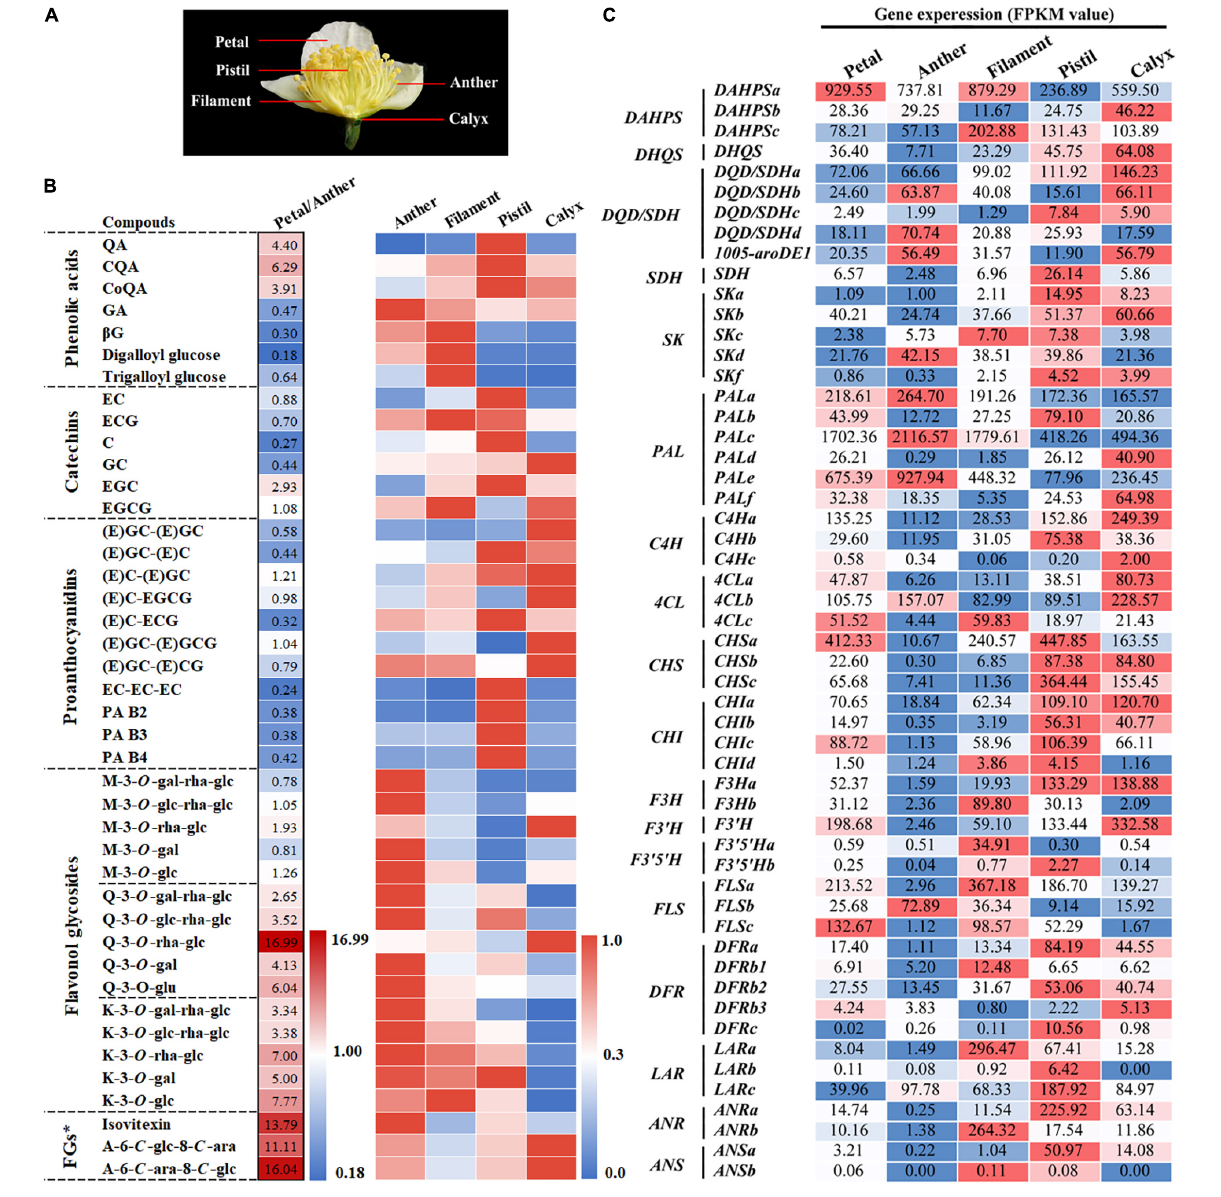
FIGURE 3 | Metabolic analysis of phenolic compounds and expression analysis of related biosynthetic genes in different parts of tea flowers. (A) Phenotypes of different parts of the flower. (B) Metabolic analysis of the main phenolic compounds in different parts of tea flowers. The petal/anther data were relative peak area comparisons of the petal to the anther. The peak area data of anthers, filaments, pistils, and calyxes were processed and fell into the interval [0, 1] according to the ratio. FGs*, Flavone glycosides. (C) Expression analysis of genes in the shikimate, phenylpropanoid, and flavonoid pathways in different parts of the tea flower. The value represents the FPKM